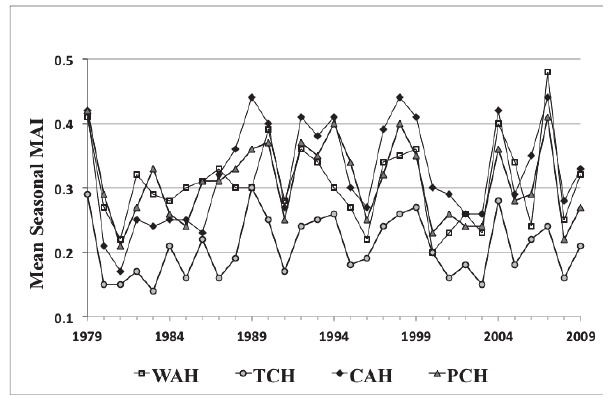
Fig. 2. Mean annual mosquito activity (daily MAI aver- aged for every season over 92 days, and entire summer range) from 1979–2009 for Western Arctic herd (WAH), Teshekpuk lake caribou herd (TCH), Central Arctic herd (CAH), and Porcupine caribou herd (PCH).